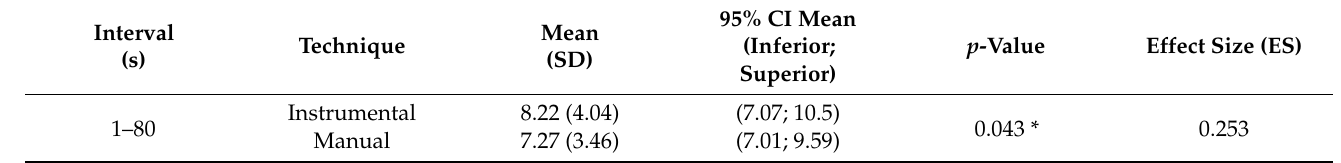
Table 2. Comparison of the mean global pressure (N/cm 2